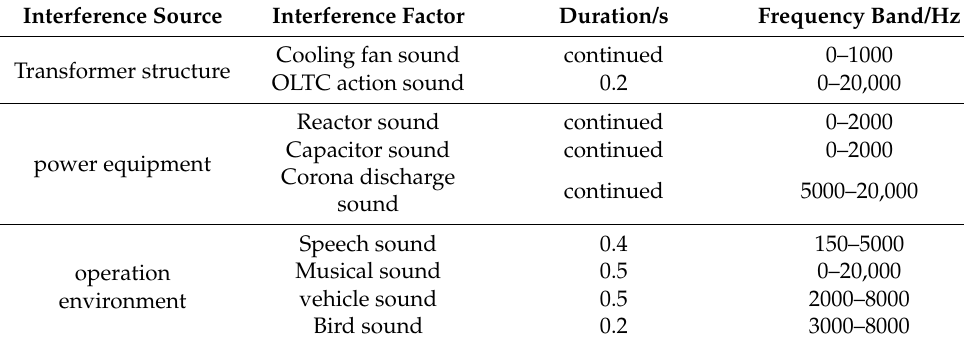
Table 1. Classification and main characteristics of interference